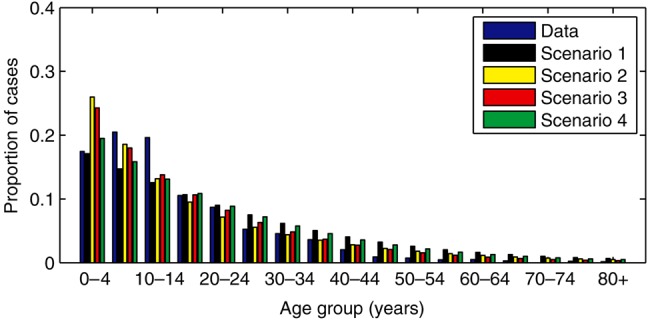
Age distribution of culture-confirmed Salmonella Typhi infections at Queen Elizabeth Central Hospital in Blantyre, Malawi. The observed proportion of cases in each age group diagnosed between October 2010 and February 2015 is indicated by the blue bars, while the other bars represent the model-predicted age distribution of cases for the corresponding time period for the best-fit models under scenario 1 (black), scenario 2 (yellow), scenario 3 (red), and scenario 4 (green).